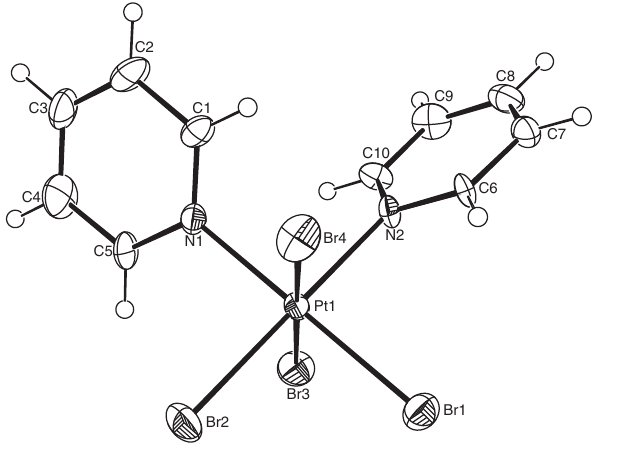
Table 2: Fractional atomic coordinates and isotropic or equivalent isotropic displacement parameters (Å 2